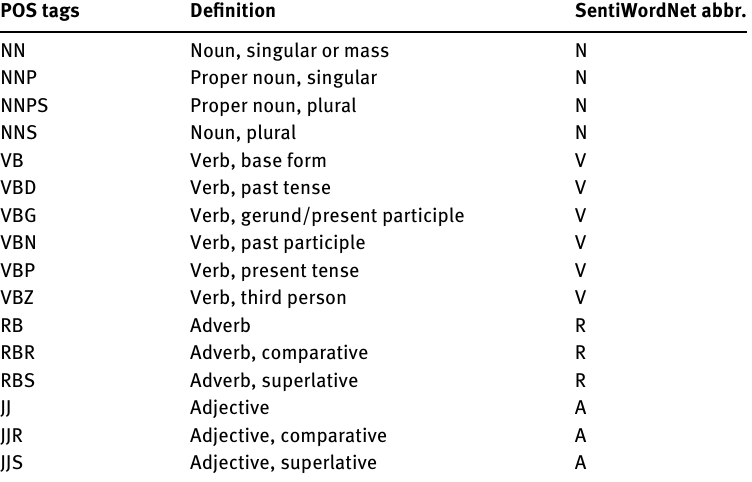
Table 2: POS Tags and